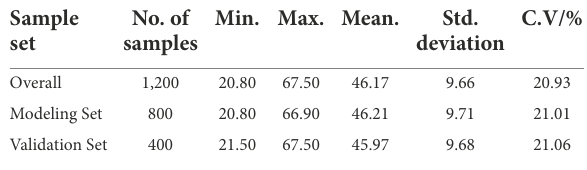
TABLE 2 Statistical characteristics of chlorophyll